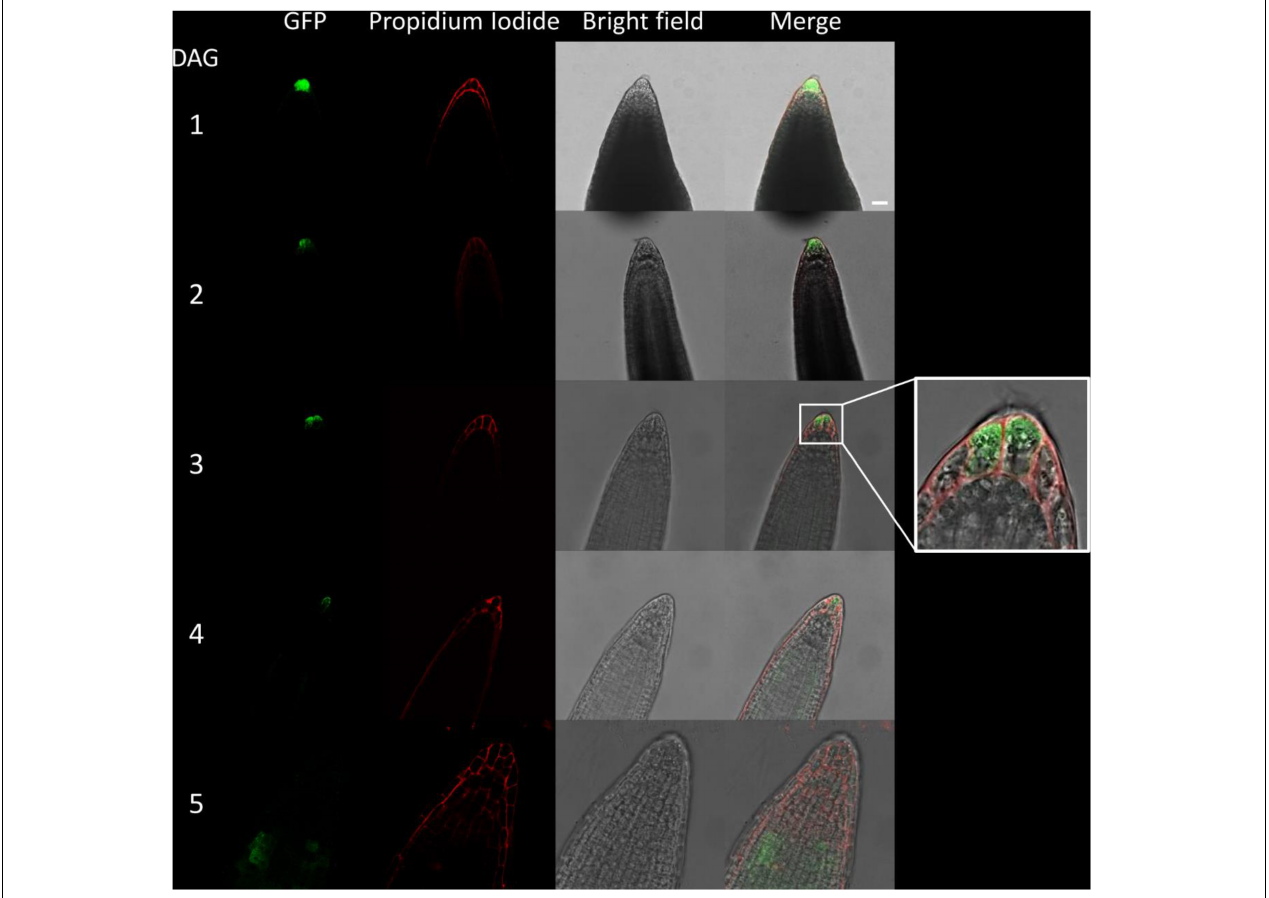
FIGURE 5 | Fluorescence imaging of CTPS2::GFP lines in young seedling roots. Seedlings were grown on 1/2 Murashige–Skoog (MS) agar plates and at the indicated time points transferred to slides with propidium iodide containing water for cell wall staining and subsequent confocal laser scanning microscopy with a Leica TCS SP5II microscope. CTPS2::GFP lines #10 and #15 were used. Typical images are shown. Scale bar = 25 µ m. DAG, days after